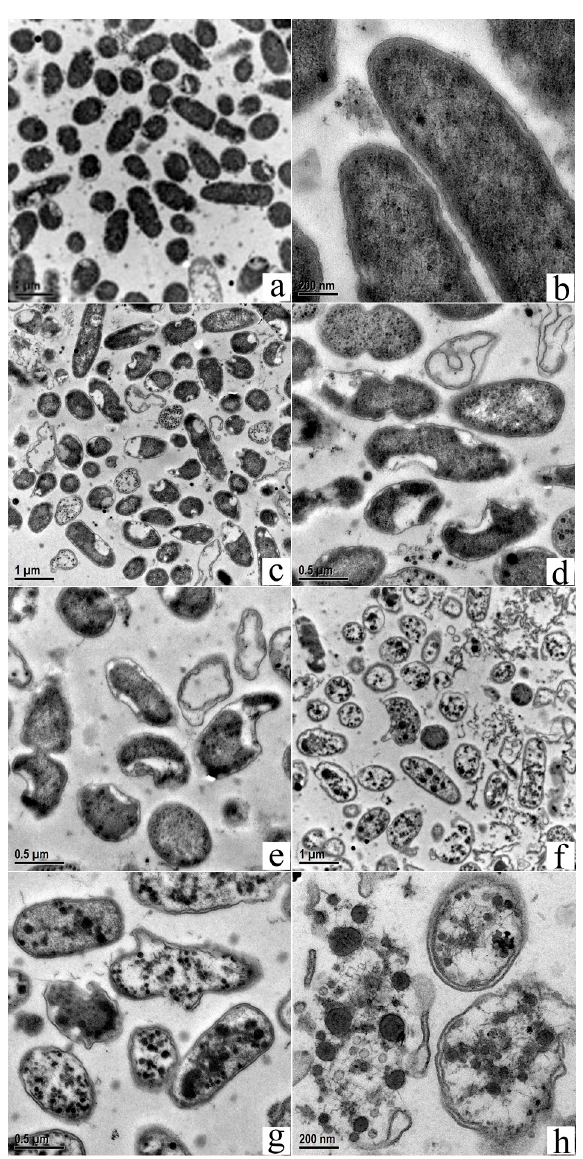
Figure 6. Transmission electron micrographs of multidrug-resistant P. aeruginosa (MDR-PA) cells showing membrane damage and changes in the intracellular structure. Control bacteria ( a , b ); approximately 9 × 10 8 CFU/mL MDR-PA cells were treated with 10 µ g/mL ( c – e ) POGH for 60 min, or with 30 µ g/mL ( f – h ) POGH for 60 min. Magnification times (( a , c , f ), 10,000 × ; ( d , e , g ), 20,000 × ; ( b , h ), 50,000 × ).